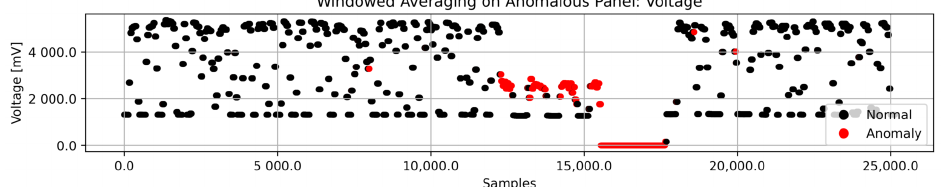
Figure 9. Initial voltage data plot after windowed averaging.